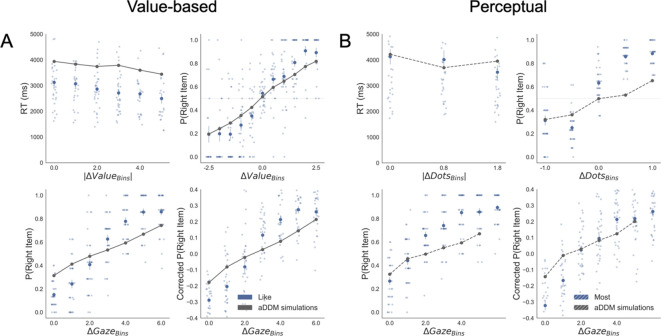
Replication of behavioural effects by aDDM simulations for like (A) and most frames (B).The four panels present four relevant behavioural relationships found in the data. Top left: faster responses (shorter reaction time, RT) when the choice is easier (i.e. easier choices are found with higher |ΔValue| and |ΔDots| in Value an Perceptual Experiments, respectively). Top right: probability of choosing the right alternative increases when the evidence towards the right item is higher (ΔValue and ΔDots are calculated considering right minus left options). Bottom left: the probability of choosing the item on the right side of the screen depends on the gaze time difference (ΔGaze, calculated as the time observing the right minus the left item). Bottom right: gaze influence on choice depending on the difference in ΔGaze (check Results section for more details on gaze influence). Solid blue dots depict the mean of the data across participants in like and most frames. Light blue dots show the mean value for each participant. In Value Experiment, the solid grey lines show the average for model simulations. In the Perceptual Experiment, segmented grey lines show the average for model simulations. Data and simulations were binned for visualisation.